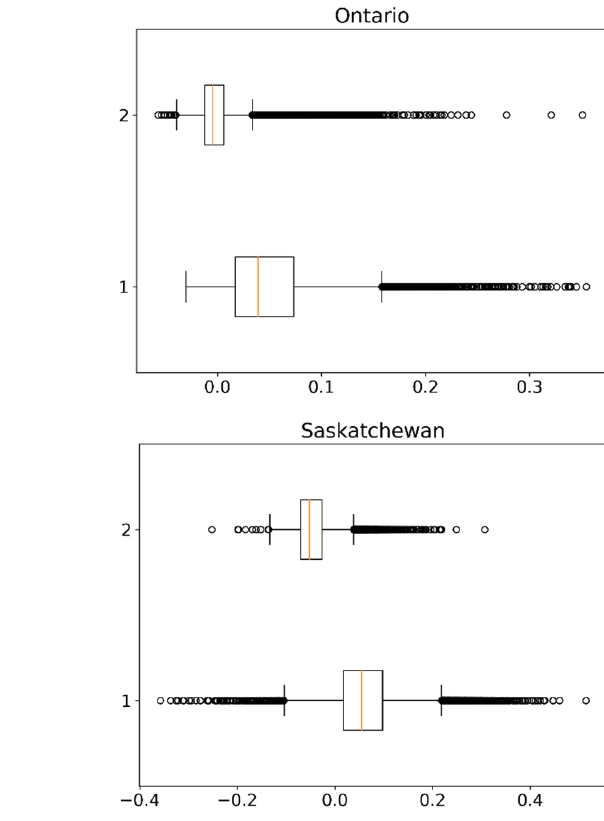
Figure 4. False positive values and urban/built-up areas in Alaska ( a ) and Saskatchewan ( b ) case study areas.